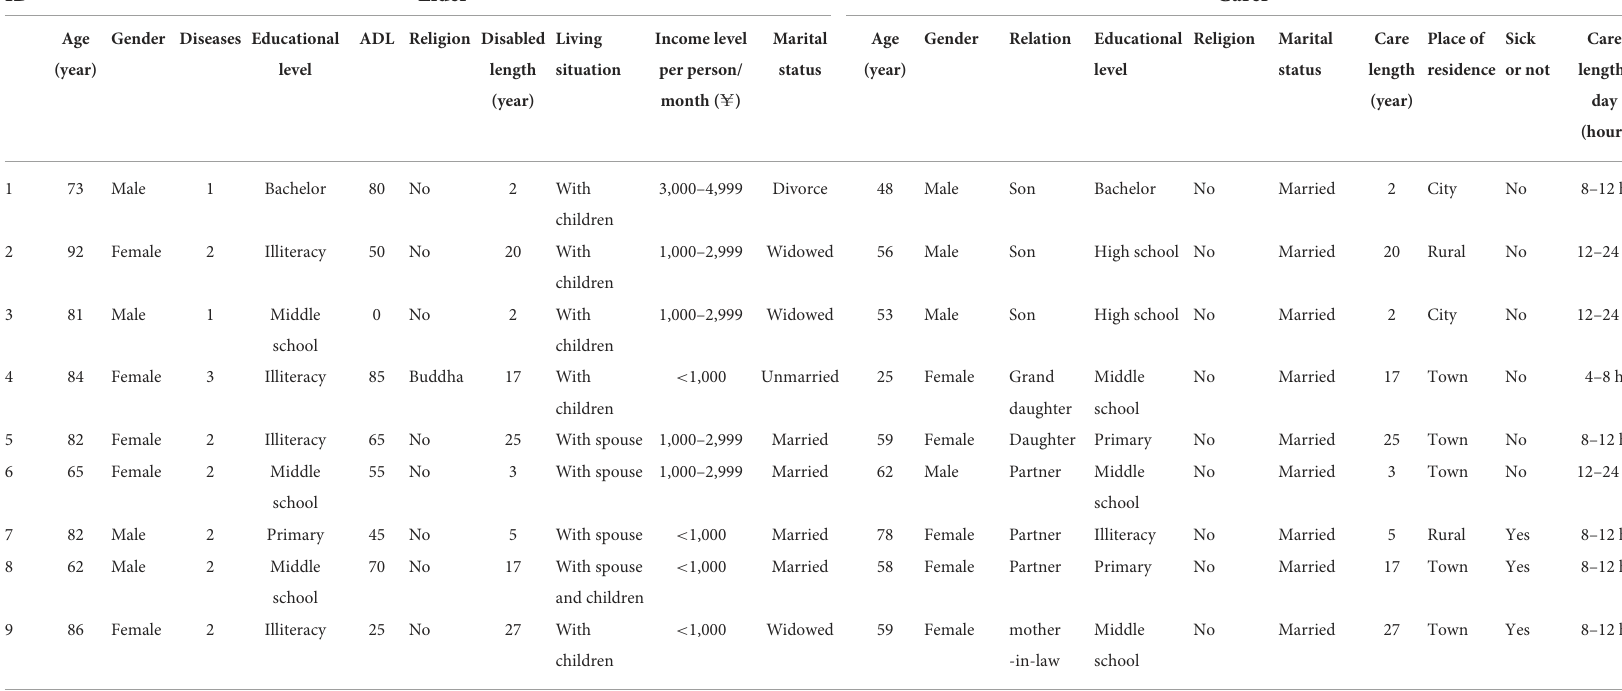
TABLE 1 General information of the disabled elderly and